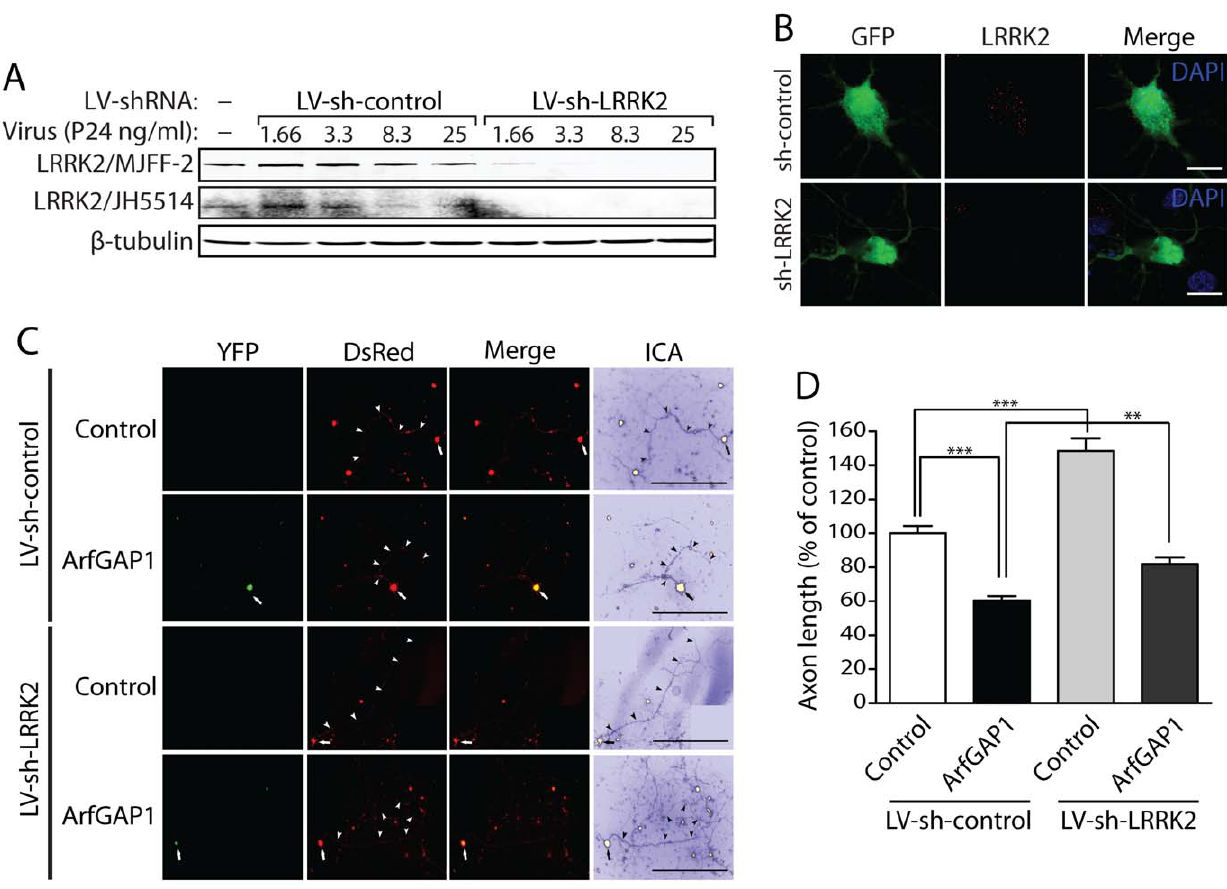
Figure 11. Silencing of LRRK2 expression rescues ArfGAP1-induced neurite shortening. (A) Validation of short hairpin RNA (shRNA)- mediated silencing of endogenous LRRK2 expression in rat primary cortical neuronal cultures. Lentiviral vectors expressing non-silencing shRNA (LV- sh-control) or LRRK2-specific shRNA (LV-sh-LRRK2) were used to infect primary neurons at increasing viral doses ranging from 1.66 to 25 ng of P24 antigen per ml of media. Western blot analysis of neuronal extracts reveals the viral dose-dependent knockdown of LRRK2 with LRRK2-specific shRNAs but not control shRNA using two independent rabbit LRRK2 antibodies (MJFF-2/c41-2 or JH5514). b -tubulin indicates equivalent protein loading. (B) Silencing of endogenous LRRK2 expression in GFP-labeled cortical neurons with lentiviral-shRNA vectors revealed by confocal fluorescence microscopy with a rabbit anti-LRRK2 antibody (JH5514). (C) Primary cortical neurons were infected with lentiviral vectors expressing shRNAs (non-silencing control or LRRK2-specific) at DIV 2, subsequently transfected with ArfGAP1-YFP and DsRed constructs at a 10:1 molar ratio at DIV 3, and fixed at DIV 6. Fluorescent microscopic images reveal the co-labeling of cortical neurons with ArfGAP1-YFP and DsRed. DsRed images were pseudo-colored with ICA for neurite length measurements. Neuronal soma ( arrows ) and axonal processes ( arrowheads ) are indicated. Scale bars: 400 m m. (D) Analysis of DsRed-positive axonal processes reveals a robust shortening of axons induced by ArfGAP1 expression and increased axon length induced by silencing of LRRK2 with LV-sh-LRRK2 vector, compared to DsRed alone (control). Silencing of LRRK2 with LV-sh-LRRK2 produces a partial rescue of ArfGAP1-induced axon shortening compared to LV-sh-control. Bars represent mean ( 6 SEM) length of axons expressed as a percent of DsRed alone (control/LV-sh-control) from . 85 DsRed-positive neurons from two independent experiments/cultures. ** P , 0.01 and *** P , 0.001 compared to control (LV-sh-control/DsRed alone), or by comparison of ArfGAP1/LV-sh-control with ArfGAP1/LV-sh-LRRK2, by one-way ANOVA with Newman-Keuls post-hoc analysis. ns ,